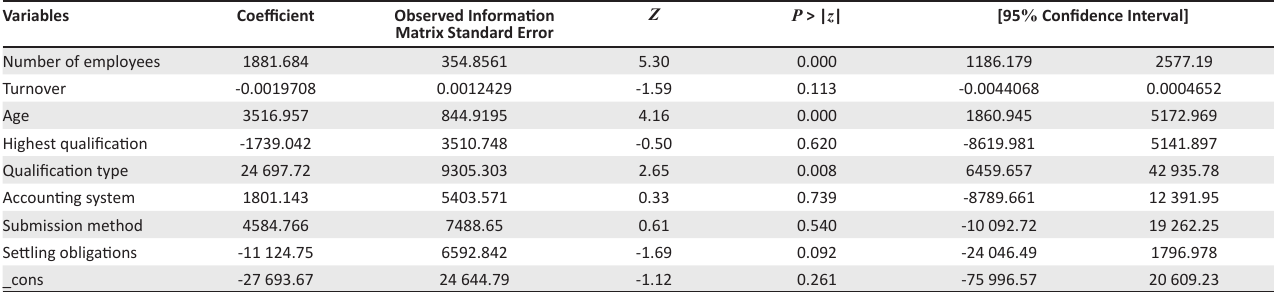
TABLE 4: Regression results with structural equation modelling. Variables